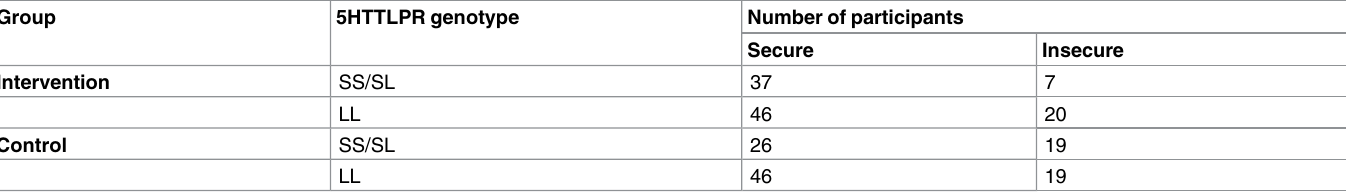
These data are shown in Fig 3 as percentages secure and insecure for each genotype and for all genotypes. 5HTTLPR, 5HTT- linked polymorphic